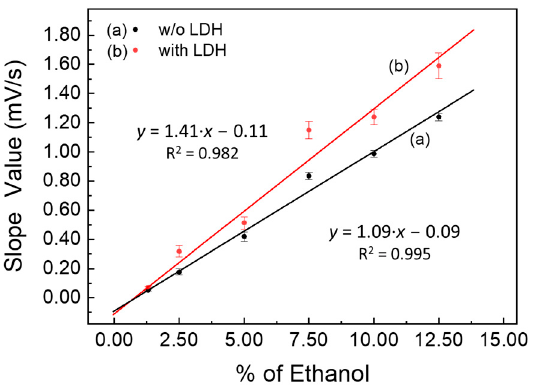
Figure 4. Calibration curves by «kinetic methods» (slope values vs. increasing percentage of ethanol), both in the absence ( a ) and in the presence of LDHs (63 mg) ( b ).